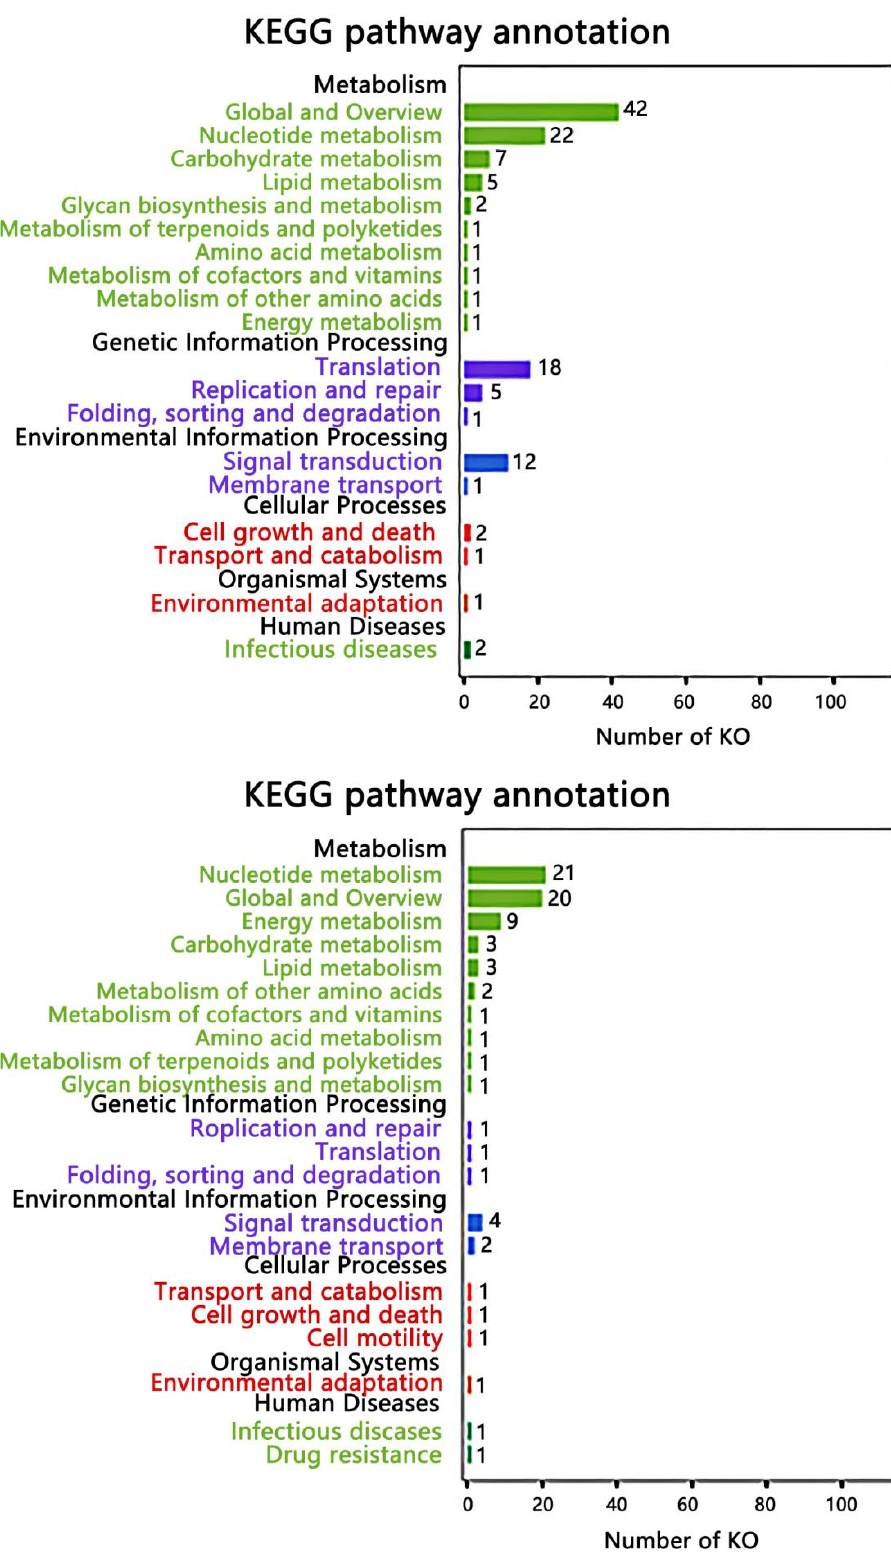
Figure 5. Metagenomic analysis of Mycoplasma in intestines of diseased abalones. The horizontal coordinates represent the number of KO pathways, and the vertical coordinates represent the names of the KEGG pathway.